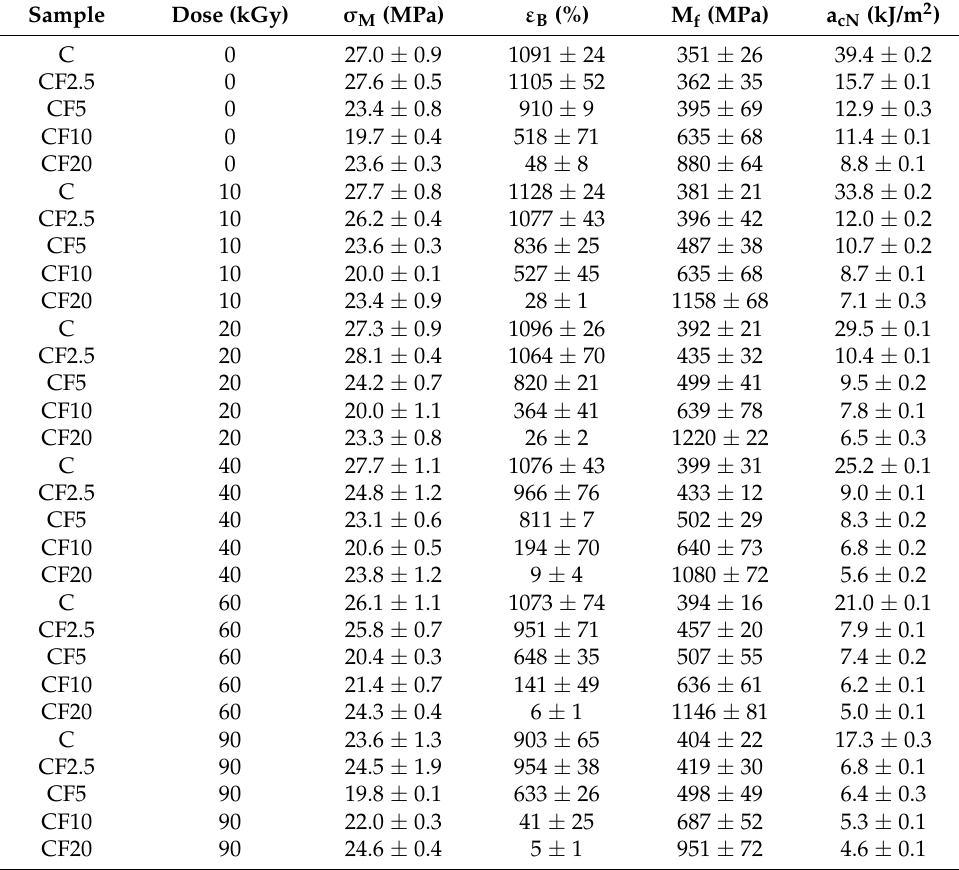
Figure 7. Impact strength results. Table 2. Mechanical properties of pristine PCL, PCL/HF composites, irradiated PCL and irradiated PCL/HF